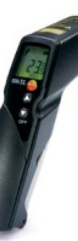
Fig. 3. Testo 830-T2 infrared thermometer